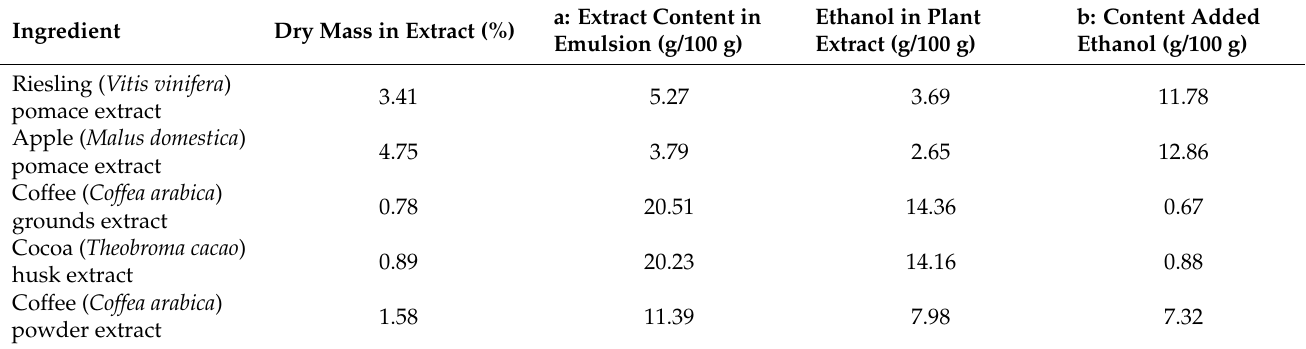
Table 2. Calculation of the plant extract